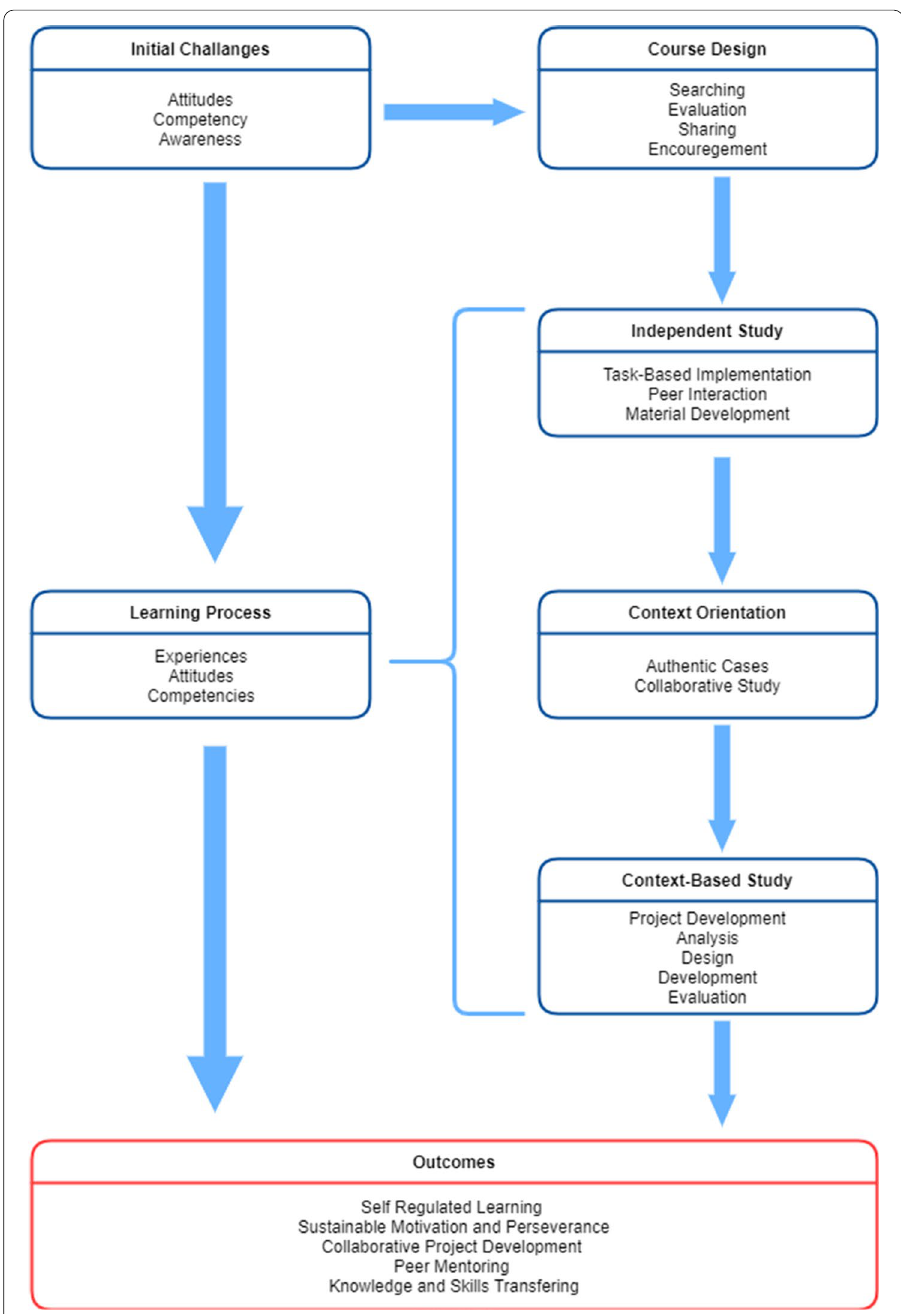
Fig. 2 Instructional technologies course design based on praxeological